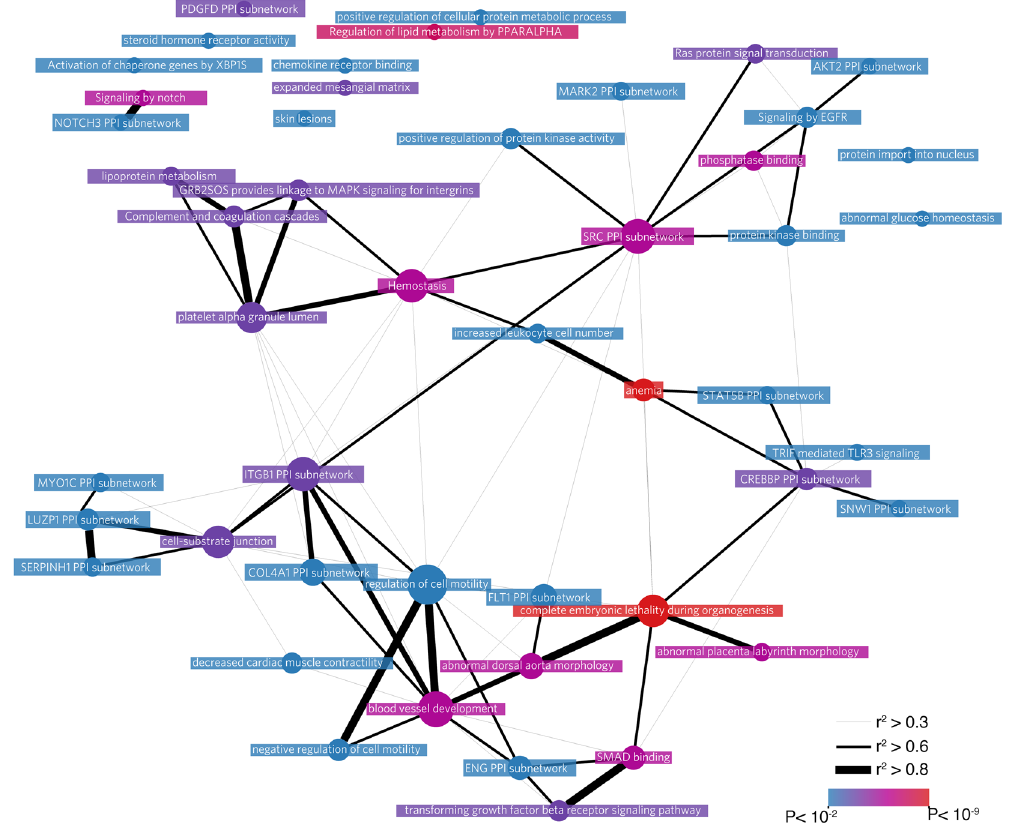
Figure 2. Gene-networks of the meta gene-sets that DEPICT prioritized at FDR < 0.05. Sizes of the nodes reflect the eigenvector centrality, an indicator of a node’s centrality in the